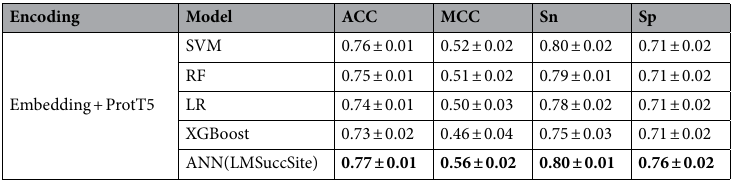
Table 3. Performance of best different ML/DL models as a meta classifier. Highest values in each category are in